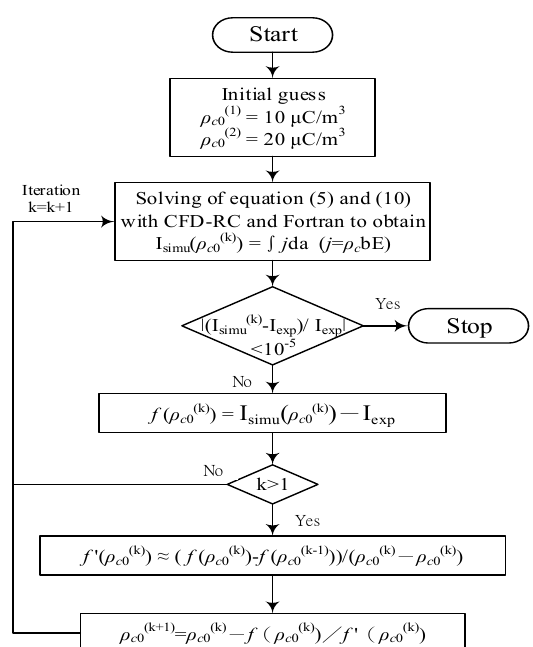
Figure 2. Flowchart for the charge density of the electrode surface with Newton’s method.